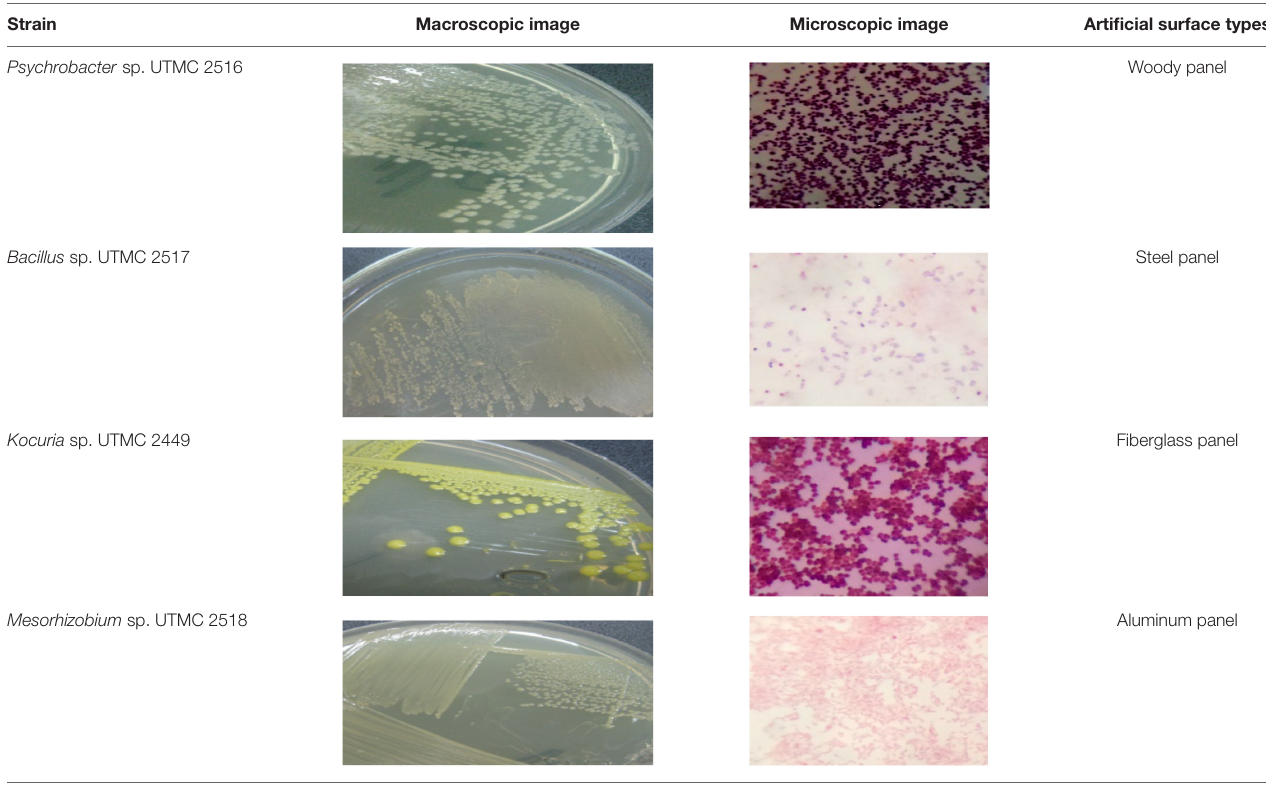
TABLE 2 | Microscopic and macroscopic characteristic of the dominant marine biofilm bacteria obtained from Oman